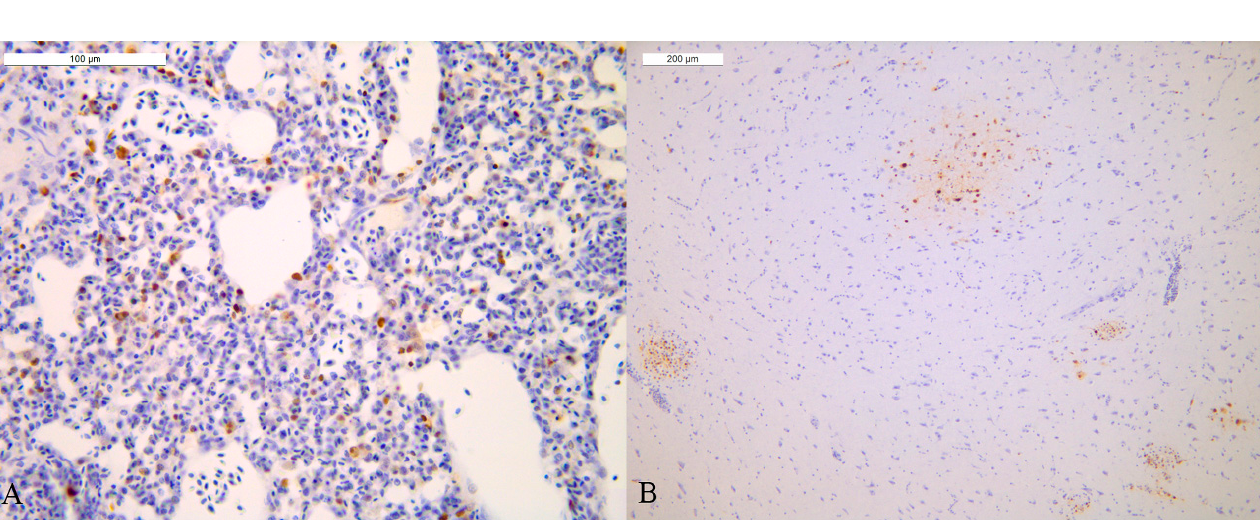
Figure 6. Lung and brain of one broiler of house 1 (IHC) ( A ) Lung: moderate number of positive pneumocytes and macrophages detected as nuclear brown staining (+++ score), ( B ) brain: moderate number of positive neurons and microglial cells detected as nuclear brown staining (+++ score).